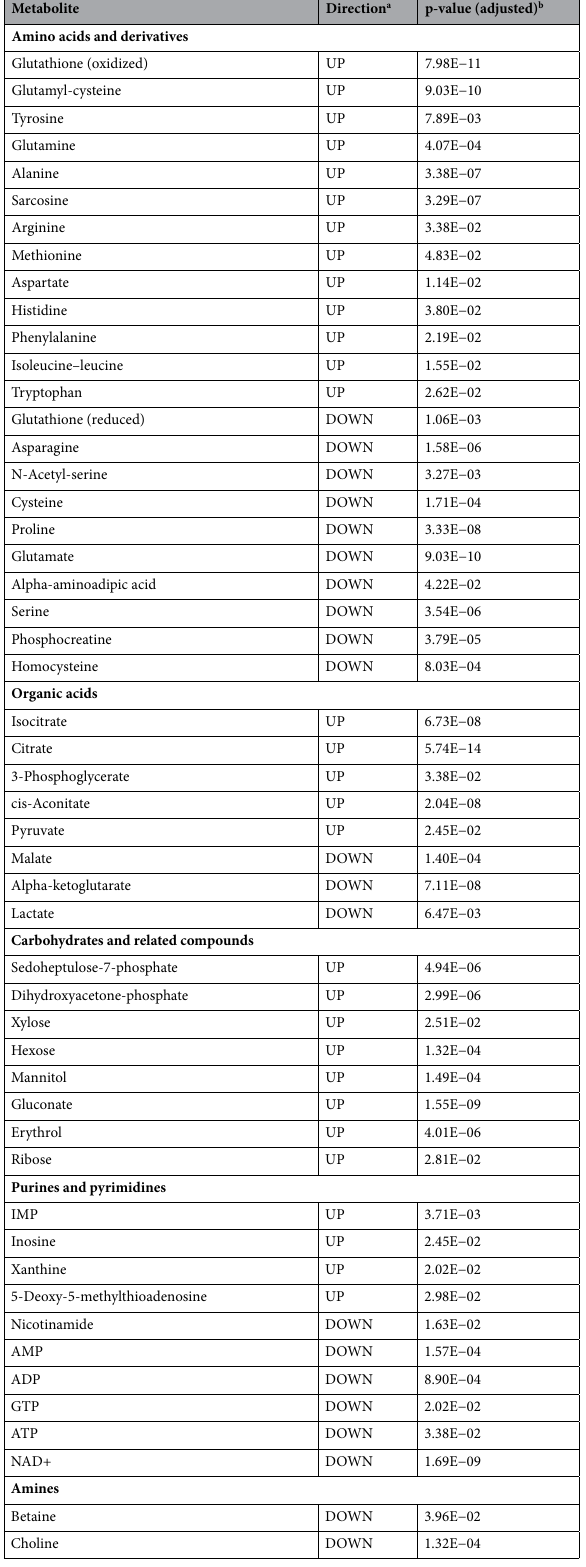
Table 1. Significantly altered metabolites upon hydrogen peroxide treatment. After 2 h incubation in HCT116 adenocarcinoma cell culture (N = 8, N = 8), 51 unique metabolites changed, from which 30 had higher (UP) and 21 lower (DOWN) concentration in means relative to control. a Direction of change in mean relative to control. b False discovery rate adjusted p-value with N = 8 biological